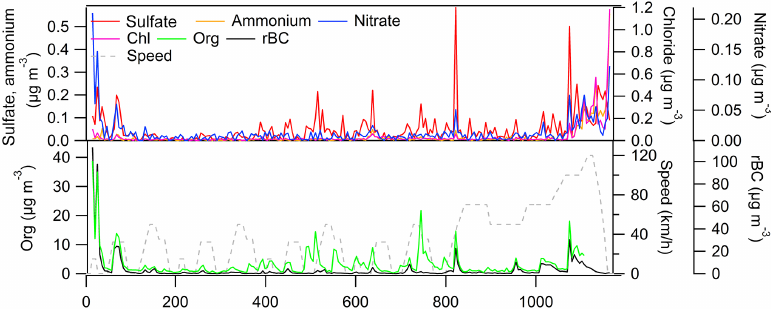
Figure 3. Temporal behavior of rBC, organics, SO 4 , NO 3 and NH 4 concentrations measured by the SP-AMS for the primary emissions (without the PAM chamber) during the NEDC test cycle.